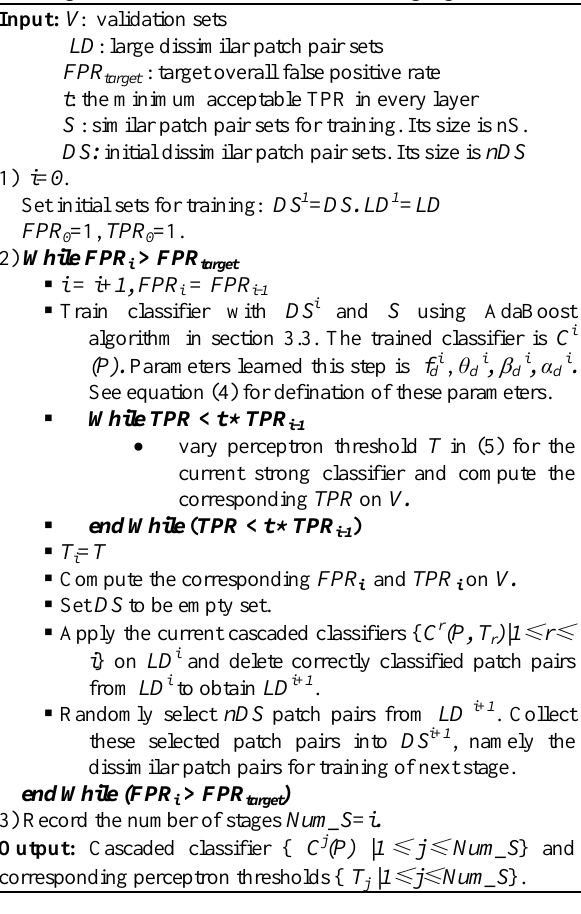
Algorithm 2. Cascaded classifier learning algorithm.